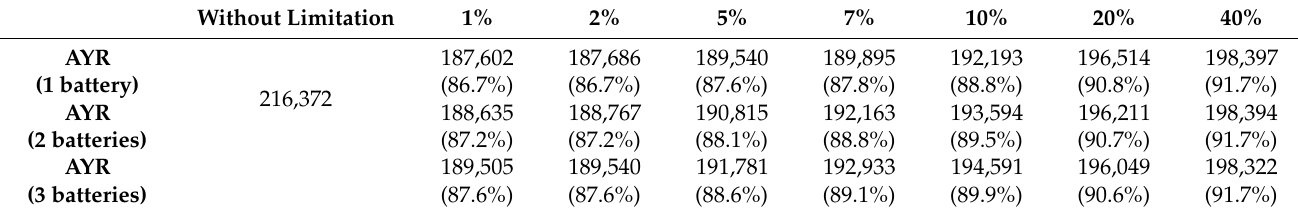
Table 8. Average Yearly Revenue (AYR) in EUR considering the mean yearly penalty and the yearly costs of the battery, and the percentage of revenue for each limitation with respect to the revenue without limitation.